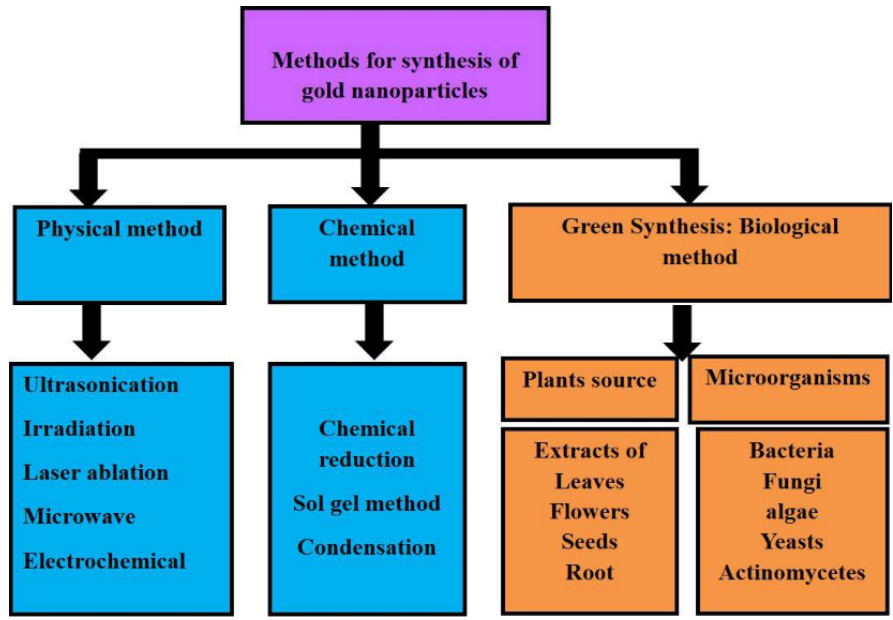
Figure 3. Different methods for synthesis of gold